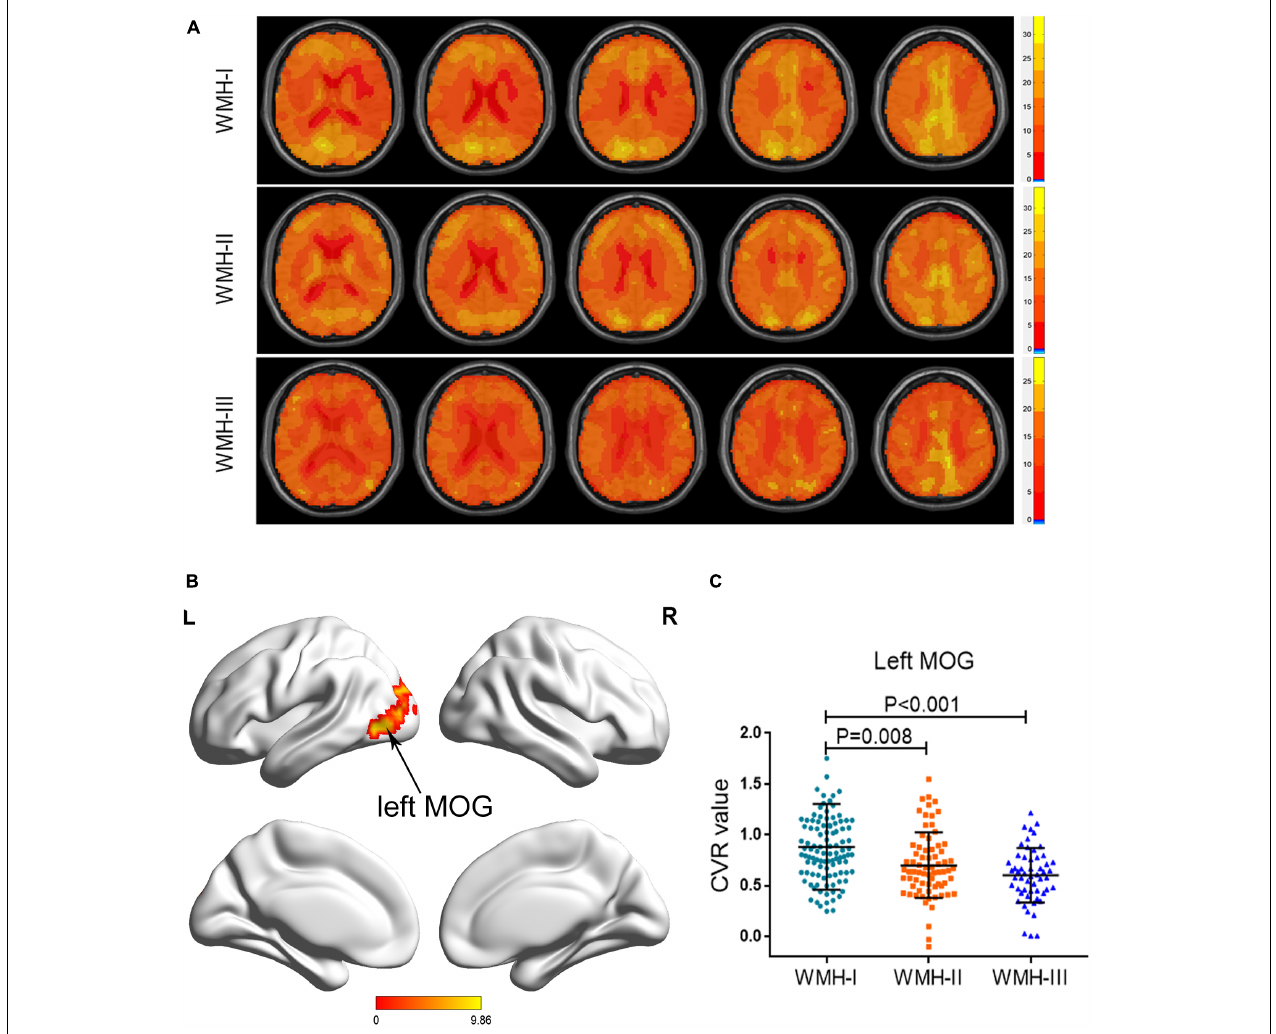
FIGURE 1 | Group differences of CVR across the three groups. (A) Axial CVR mapping for each WMH cohort. (B) The brain areas displayed a significant difference among the three groups (left MOG). (C) The subjects in the WMH-II and WMH-III groups displayed a significantly lower CVR in the left MOG than the subjects in the WMH-I group. CVR, cerebrovascular reactivity; MOG, middle occipital gyrus; WMH, white matter hyperintensity.